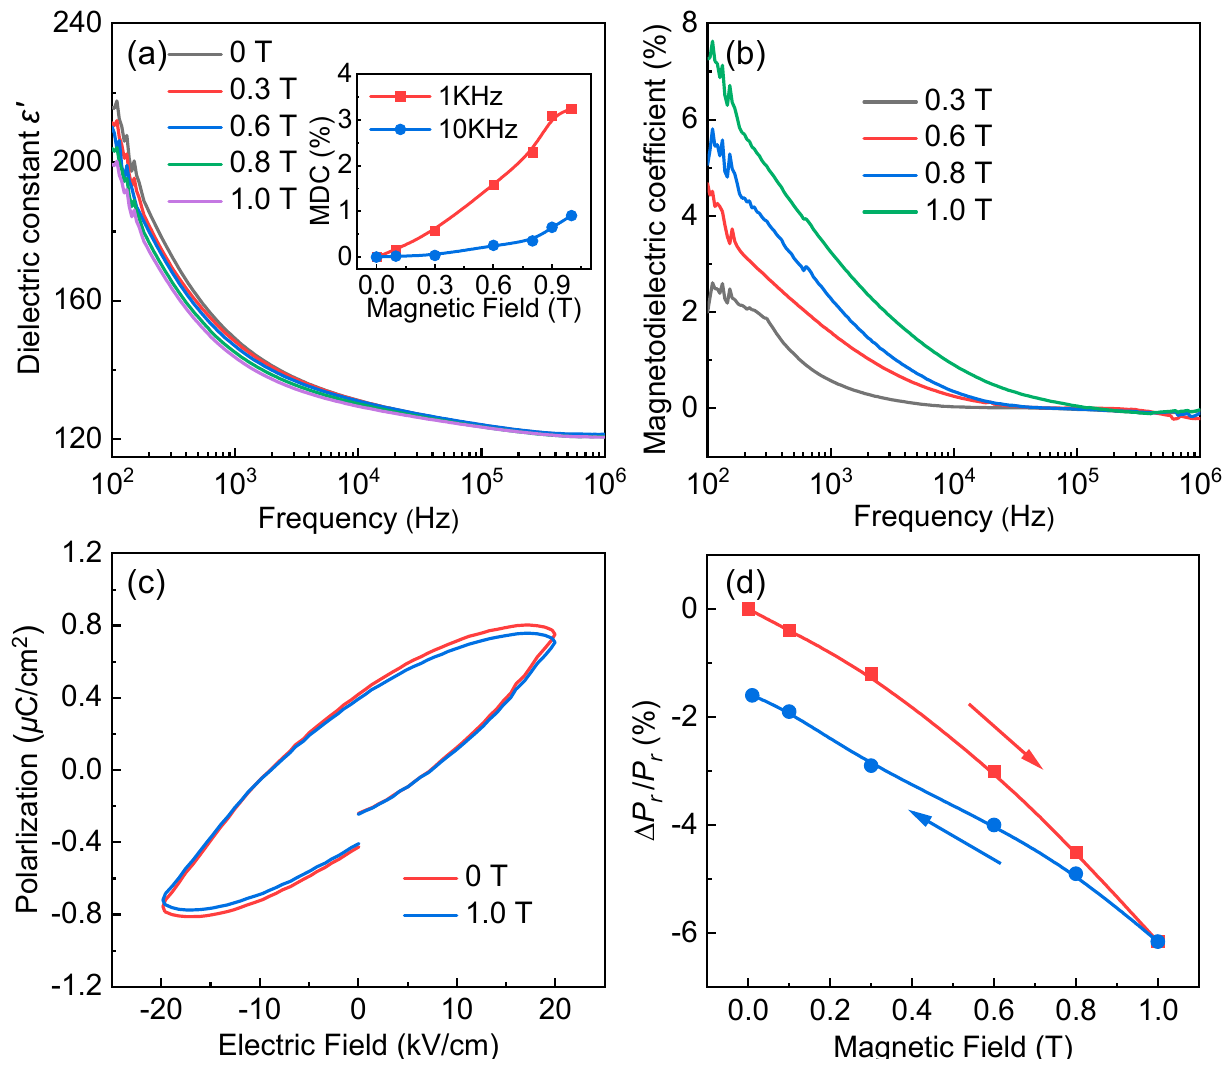
Figure 5. ( a ) Frequency dependence of ( a ) dielectric constant ε′ and ( b ) magnetodielectric coefficient (MDC) under different applied magnetic fields at room temperature, the inset of ( a ) shows the MDC dependence of the applied DC magnetic field; ( c ) P–E loops with and without magnetic field perpendicular to the thickness direction; ( d ) the estimated fractional change in Pr with H for the Pr 2 FeAlO 6 compound.